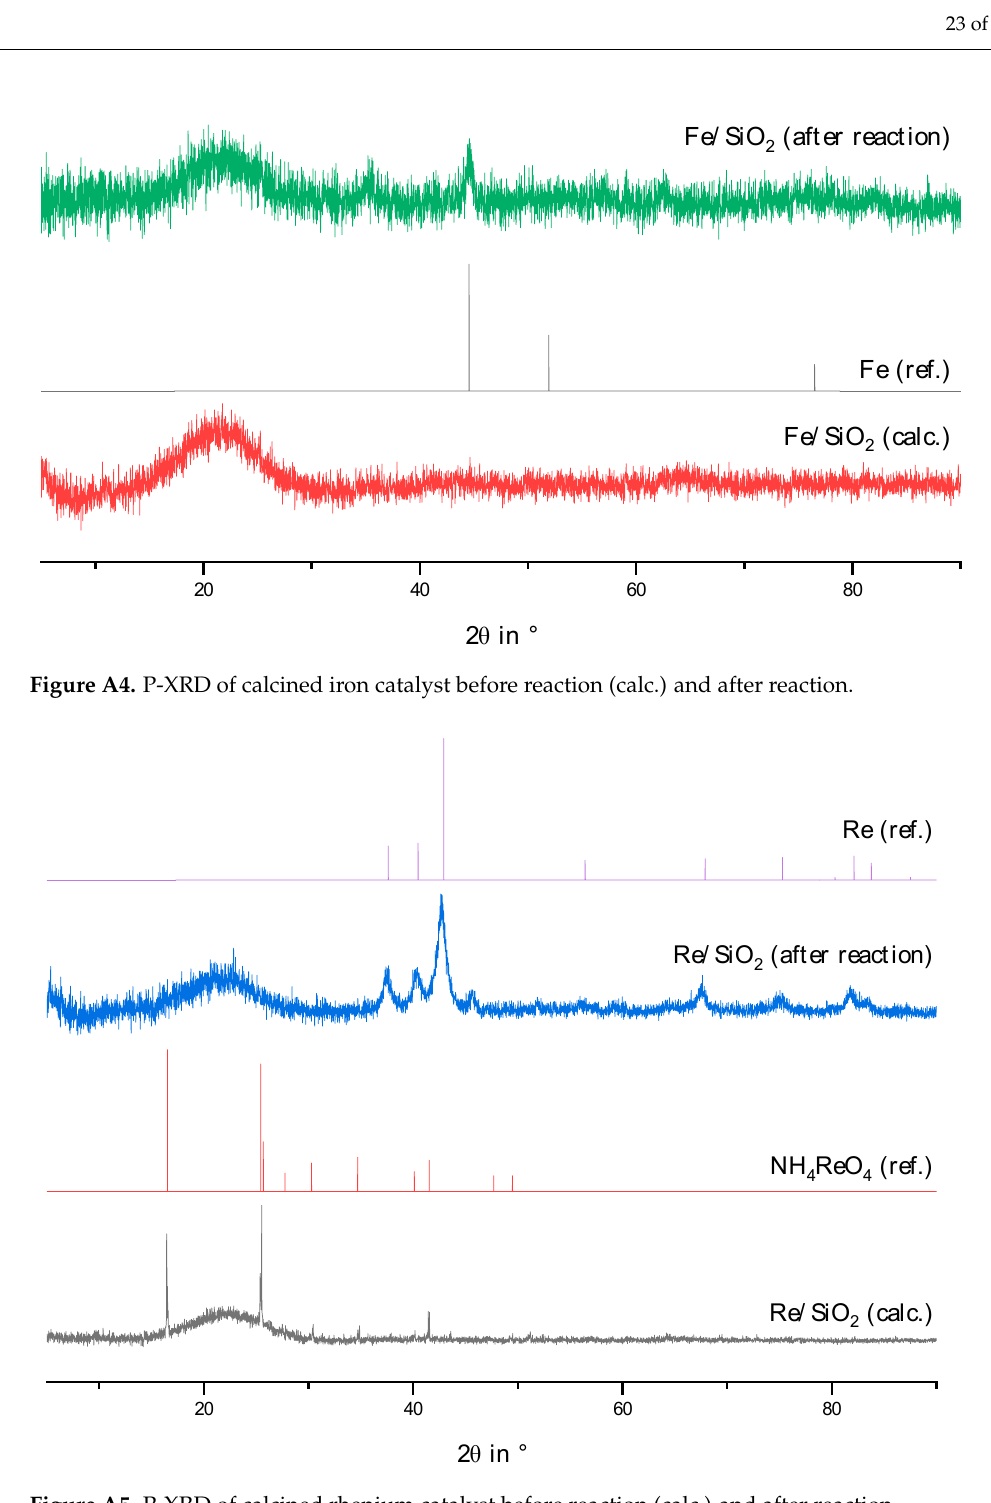
Figure A6. P-XRD of calcined cobalt catalyst before reaction (calc.) and after reaction.